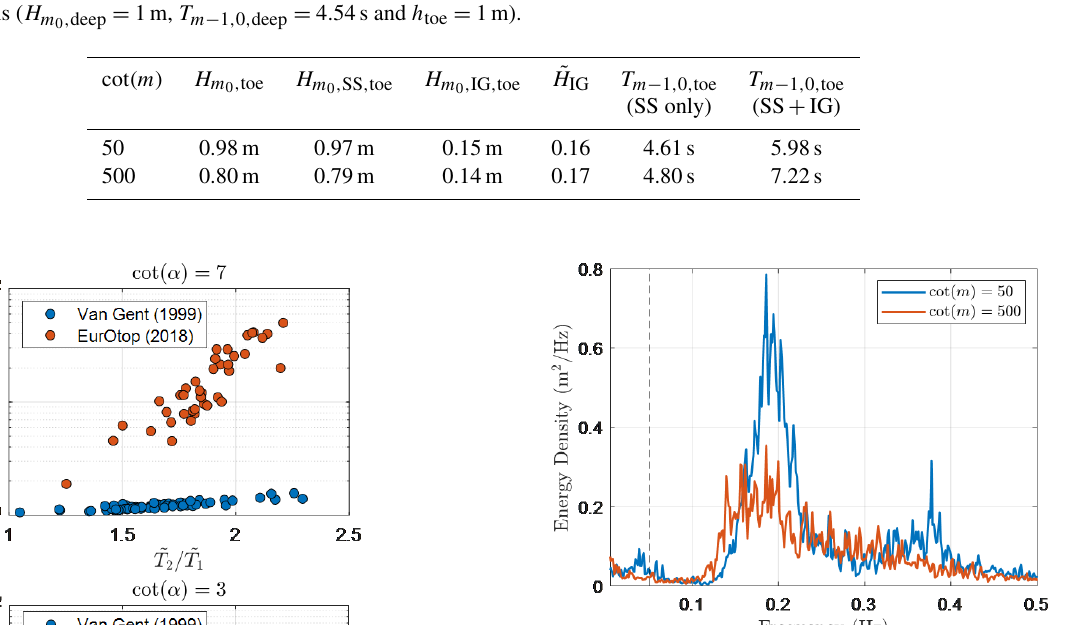
Table 4. Results of XBeach non-hydrostatic simulations taken at the dike toe for two different foreshore slopes under the same offshore